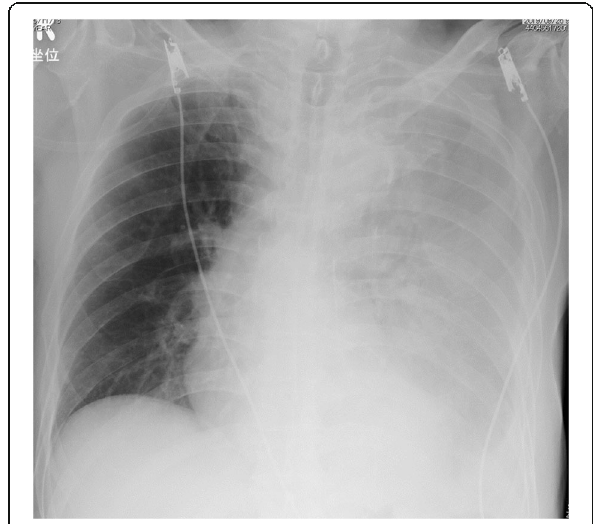
Fig. 4 Chest X-ray showing decreased permeability of the left lung field